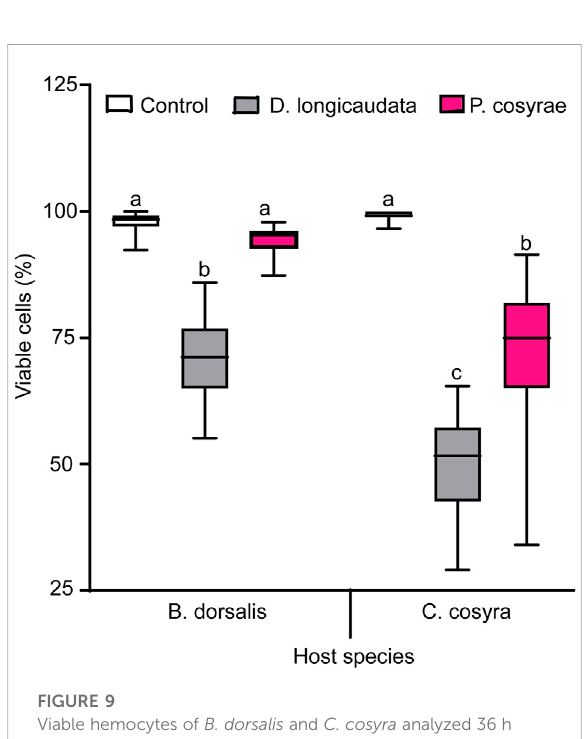
FIGURE 8 Host hemocyte spreading ability 36 h after exposure to D.